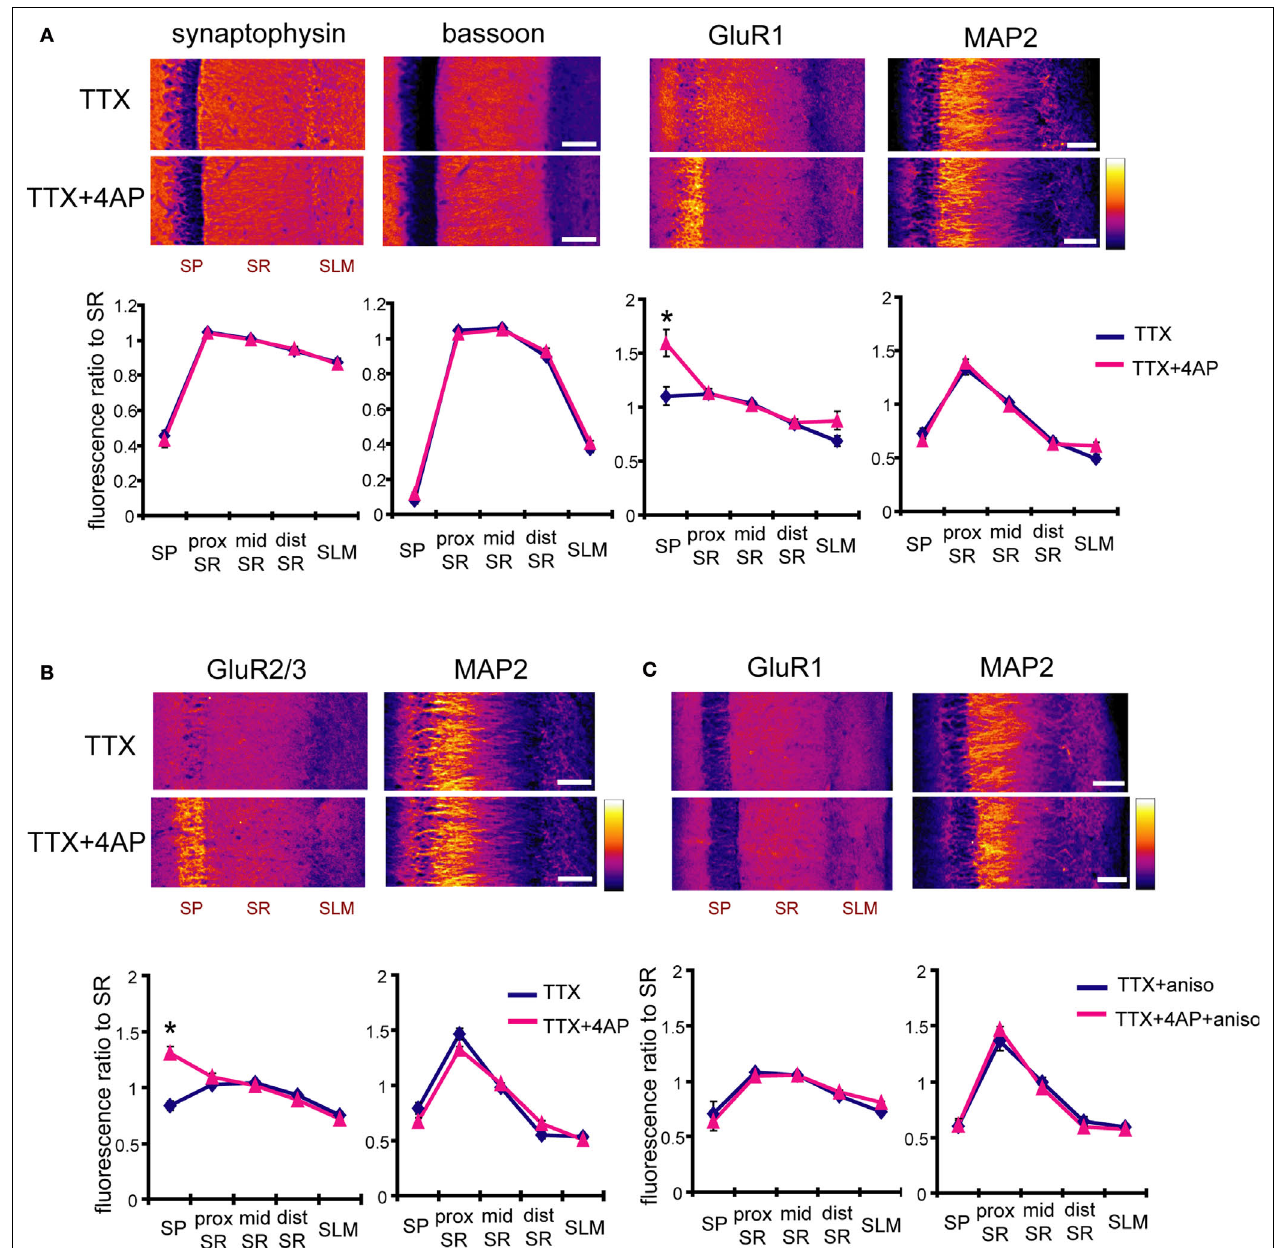
FIGURE 5 | A-type channel blockade enhances the relative density of GluR1 in the stratum pyramidale. (A) Immunohistochemistry of hippocampal slices after 12-h treatment with either TTX (2 µM) alone or TTX + 4AP (5 mM). Hippocampal slices were stained with antibodies raised against a pair of presynaptic proteins (synaptophysin and bassoon), or a pair of postsynaptic proteins (GluR1 and MAP2). The fl uorescent signal was measured along the apical dendrites from the stratum pyramidale to the stratum lacunosum-moleculare in area CA1. The stratum radiatum was equally divided into three parts; proximal, middle and distal. The fl uorescent signal was